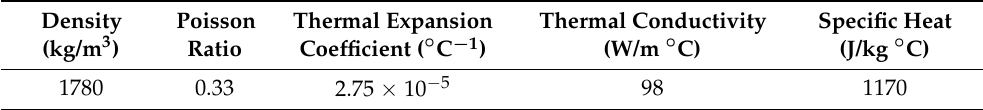
Table 2. Hot-stamping process parameters of AZ31 magnesium alloy sheet.